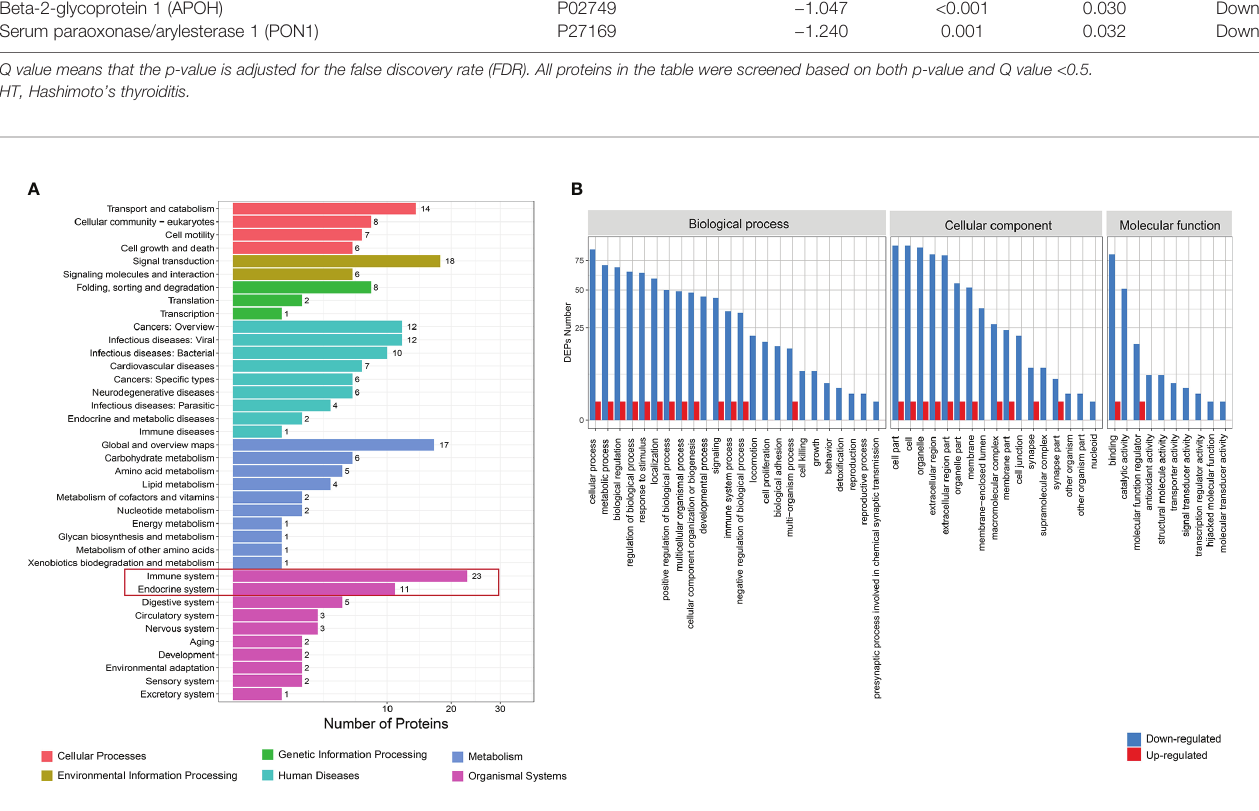
FIGURE 2 | Function analysis of differential proteins between total GD and NC groups. (A) KEGG enrichment analysis. (B) GO analysis for upregulated and downregulated proteins. GD, Graves ’ disease; NC, normal control; KEGG, Kyoto Encyclopedia of Genes and Genomes; GO, Gene